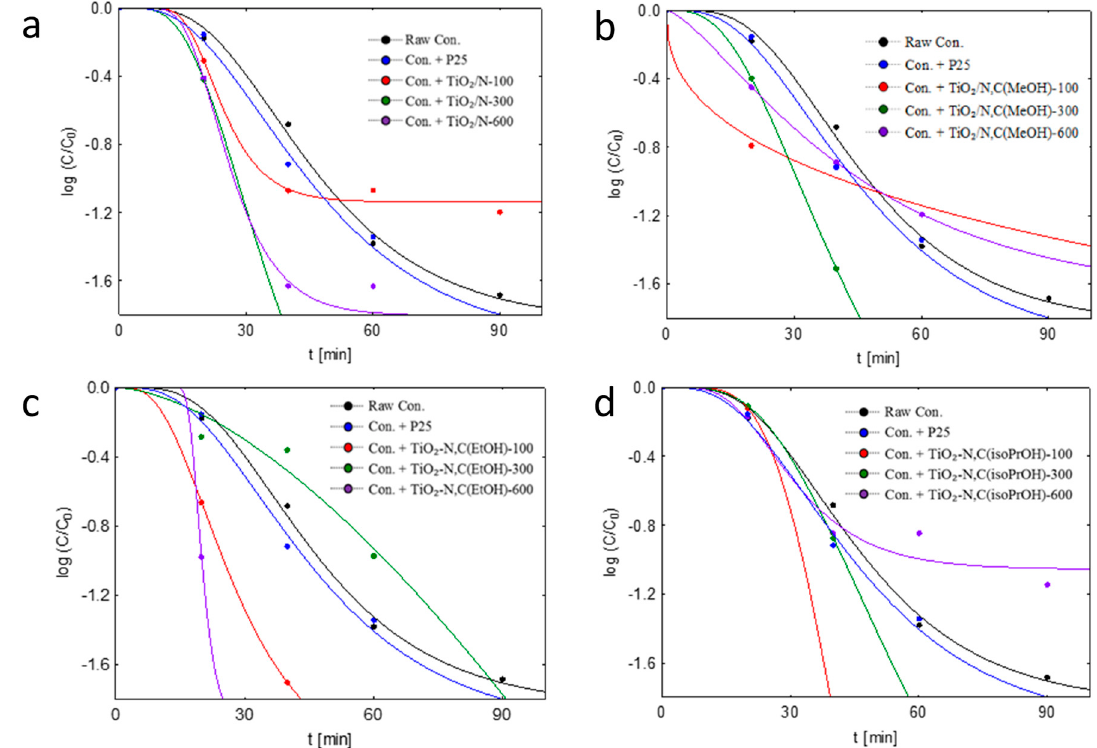
Figure 4. Fitting of the modified Hom kinetic model to experimental data of the photocatalytic inactivation of bacteria in suspension with tested raw concrete plates, plates implemented commercial TiO 2 P25 and ( a ) TiO 2 / N photocatalysts, ( b ) TiO 2 / N,C MeOH , ( c ) TiO 2 / N,C EtOH and ( d ) TiO 2 / N,C iso-PrOH under artificial solar light radiation.